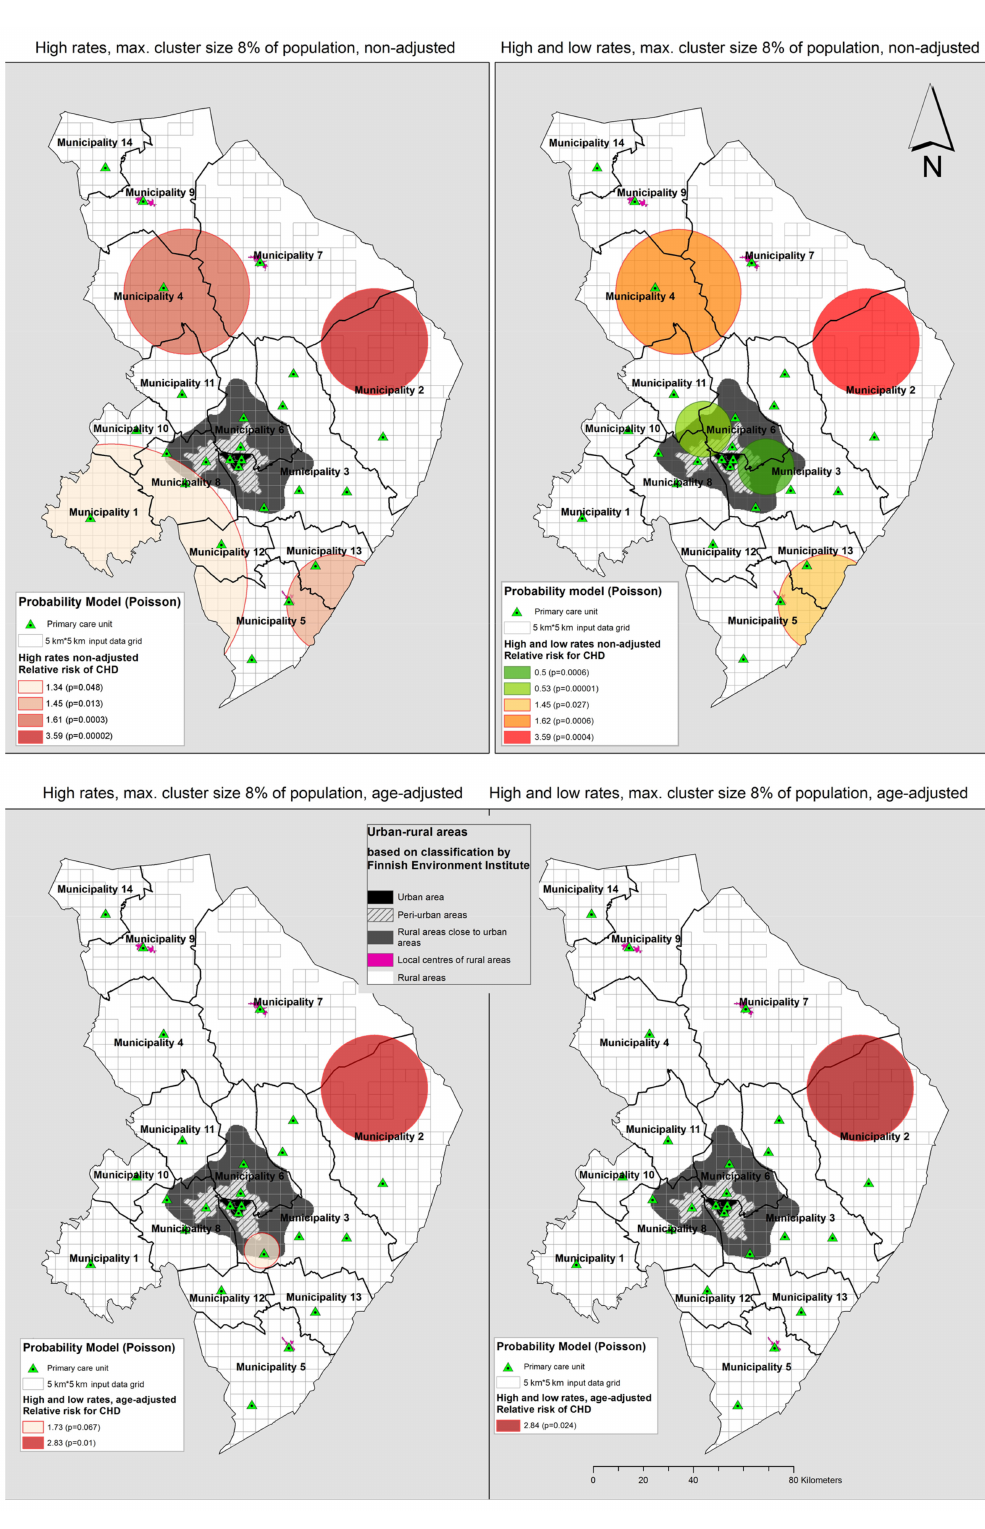
Figure 3. Disease clusters and low risk clusters of acute coronary heart disease and/or invasive treatment in 2011–2014 analysed at cluster size of maximum 8% of population at risk in North Karelia Hospital